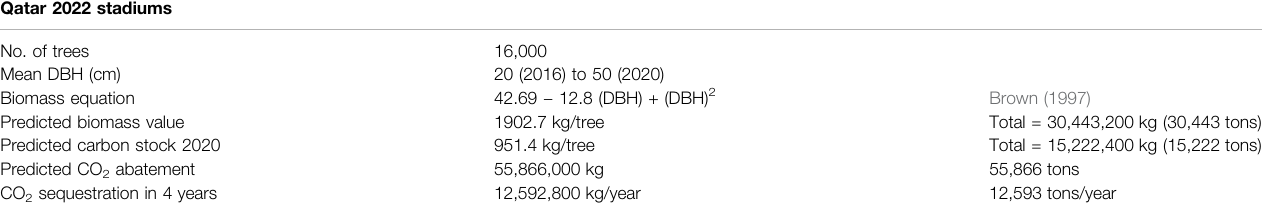
TABLE 10 | Rough estimations of the AGB, AGC, and CO 2 sequestration values of the trees nursed and planted for the FIFA World Cup Qatar 2022. Qatar 2022 stadiums No. of trees